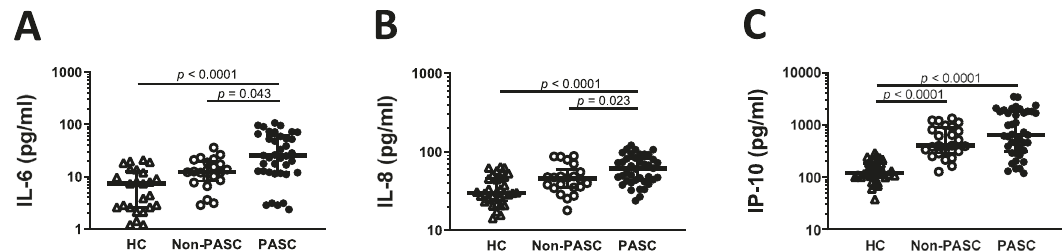
Fig. 8 | Post-COVID-19 condition associates with a higher in fl ammatory sig- nature during acute disease. The levels of IL-6 ( A ), IL-8 ( B ) and IP-10 ( C ) were quanti fi ed on the plasma of HC ( n =37) and SARS-CoV2 infected patients that develop (PASC, n =36) or do not develop (Non-PASC, n =37) post COVID-19